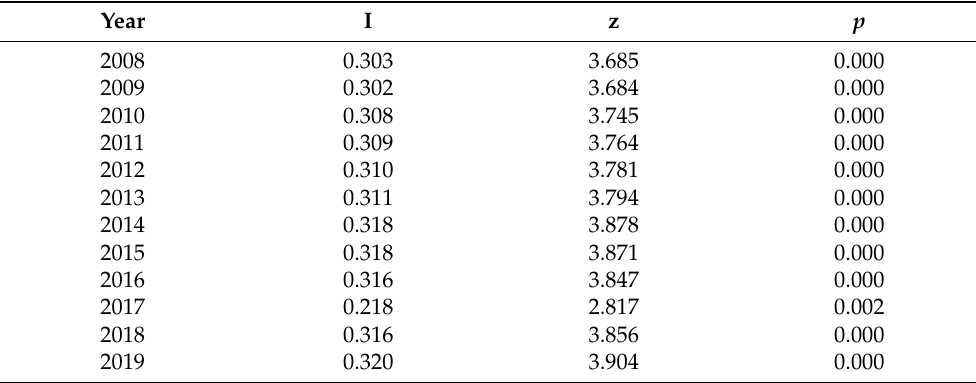
Table 4. Spatial autocorrelation results of the urban–rural income gap.